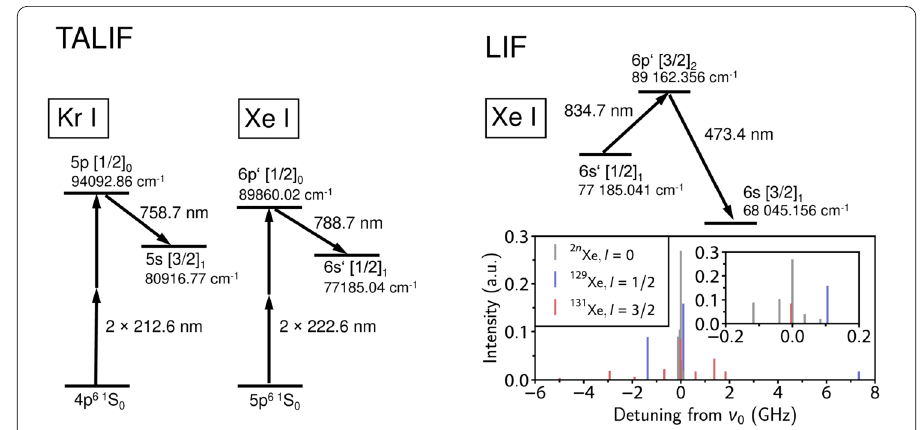
Figure 3 Excitation schemes used in the present work. Left: TALIF schemes in neutral krypton and neutral xenon. Right: LIF scheme in neutral xenon (top), spectral positions (line broadening excluded) of the hyperfine structure lines